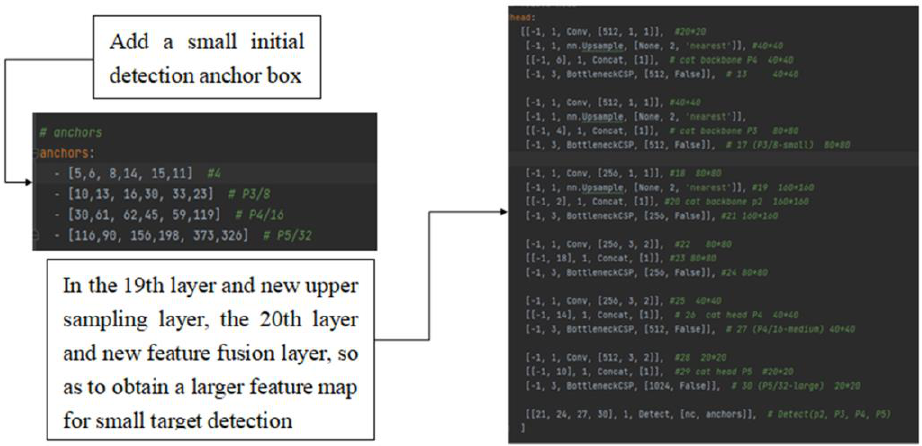
Figure 7. The modification of our proposed Yolov5 network for satellite image detection.